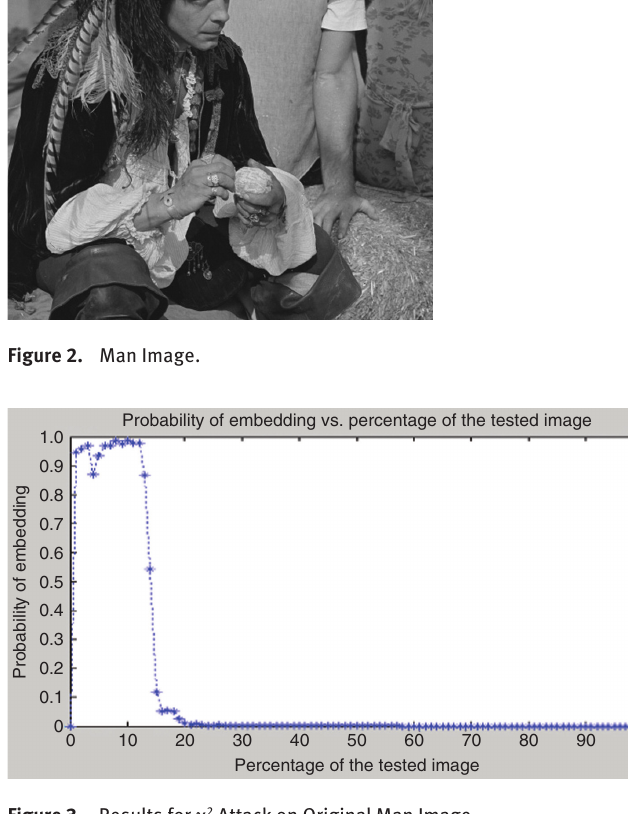
Figure 3. Results for χ 2 Attack on Original Man